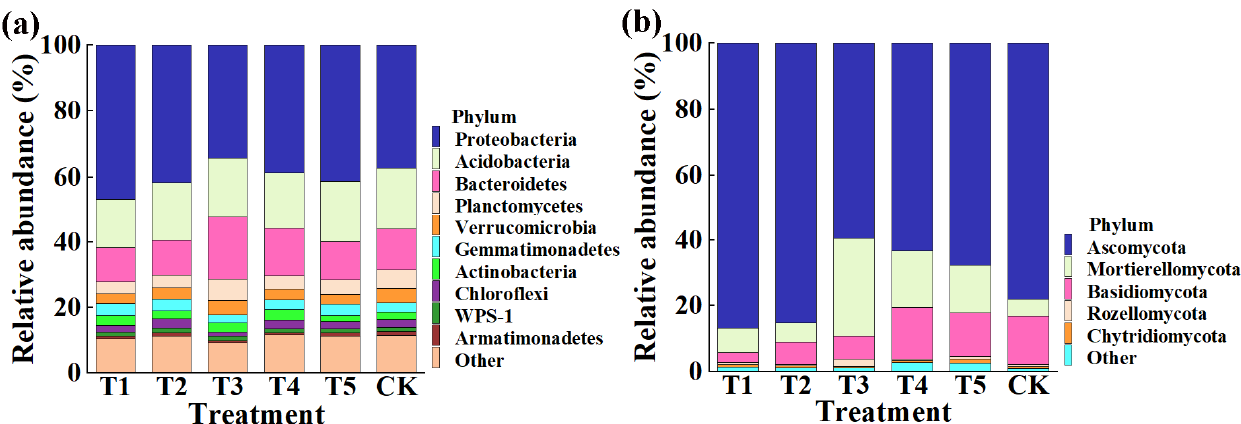
Figure 4. Relative abundance of bacteria ( a ) and fungi ( b ) at the phylum level. T1, T2, T3, T4, T5, and CK represent the treatment of Tuzangjin microbial fertilizer (TMF), carbonergic microbial agent (CMA), seaweed microbial fertilizer (SMF), sheep manure (SM), chemical compound fertilizer (CCF), and the control (CK), respectively.